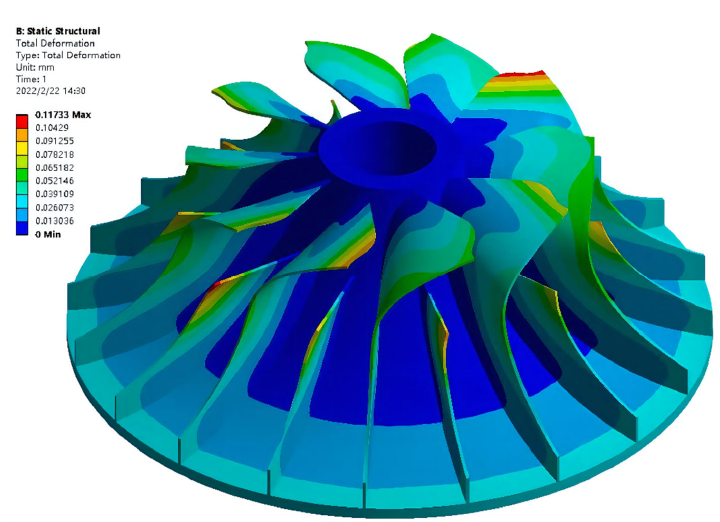
Figure 15. Total deformation of Type B.